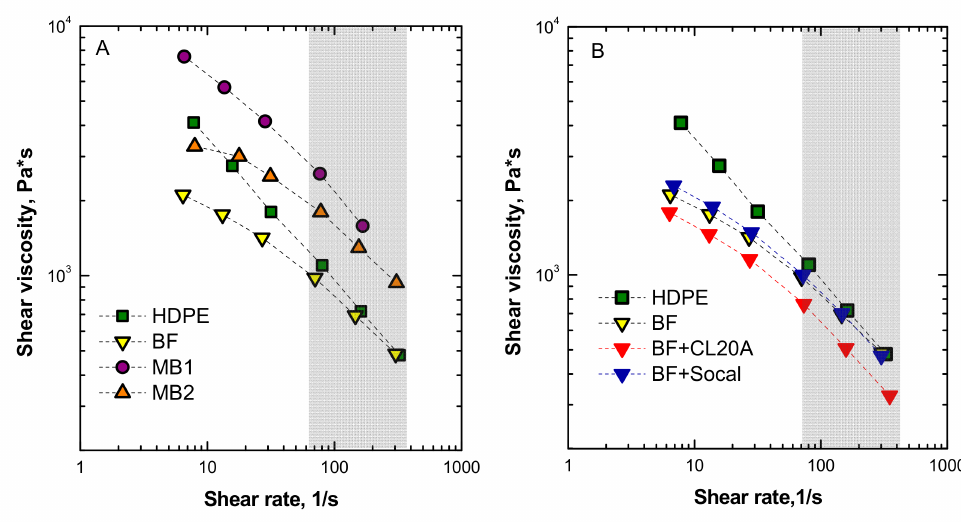
Figure 6. Shear viscosity as a function of shear rate for ( A ) unfilled matrices and ( B ) unfilled high- density polyethylene (HDPE) and BF and BF-based bionanocomposites.